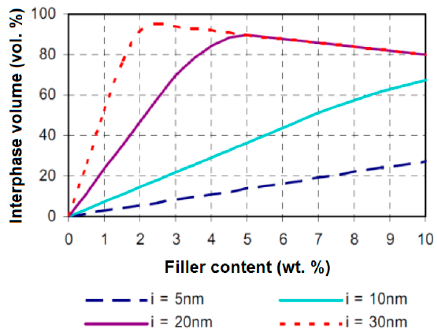
Figure 14. Interphase volume model of Raetzke for a silicone matrix and SiO 2 particles, with different interface thicknesses i (© 2016 IEEE. Reprinted, with permission, from [85]).